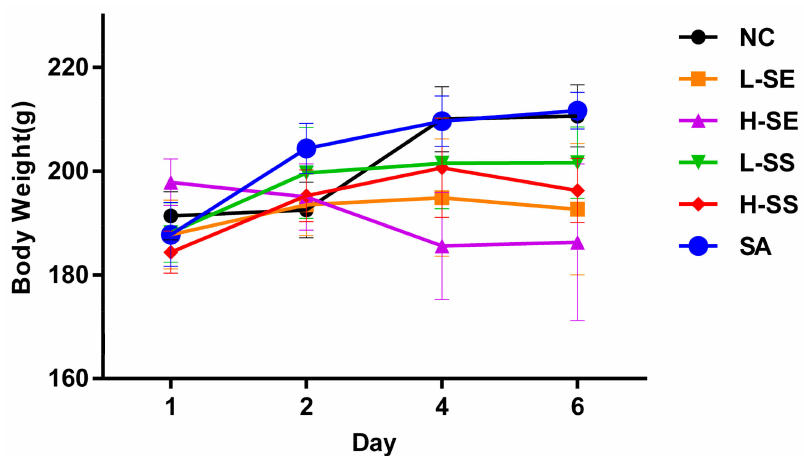
Figure 2. The transition of body weight (mean ± SD) in normal control (NC) rats and diarrhea rats induced by the low dose of senna extract (L-SE), high dose of senna extract (H-SE), low dose of sennosides (L-SS), high dose of sennosides (H-SS), and sennoside A (SA) for over six days. L-SE had a significant reduction on the mean body weight at day 4 ( p < 0.01) and day 6 ( p < 0.01). H-SE had a significant reduction on the mean body weight at day 4 ( p < 0.001) and day 6 ( p <